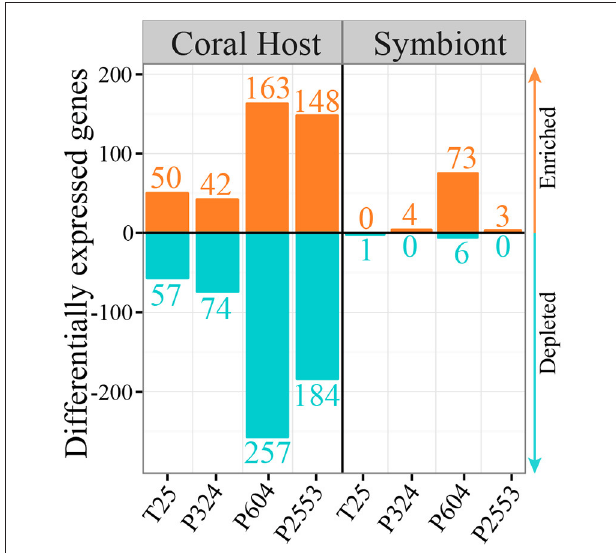
FIGURE 5 | Barplot showing numbers of significantly ( p < 0.05) differentially expressed genes (DEGs) for the host (left) and its algal symbiont Symbiodinium goreaui (right) across the four experimental treatments relative to the control for the 2862 highly conserved genes (HCG) across host and symbiont. Orange bars represent enriched genes and turquoise bars represent depleted genes in the treatment (T25 = 25.01 ± 0.14 ◦ C, 515 ± 92 µ atm; P324 = 28.14 ± 0.27 ◦ C, 324 ± 89 µ atm; P604 = 28.04 ± 0.28 ◦ C, 604 ± 107 µ atm; P2553 = 27.93 ± 0.19 ◦ C, 2553 ± 506 µ atm) relative to the control (28.16 ± 0.24 ◦ C, 477 ± 83 µ atm). Overall, hosts exhibit a much stronger response across HCGs when compared to in hospite S. goreaui , regardless